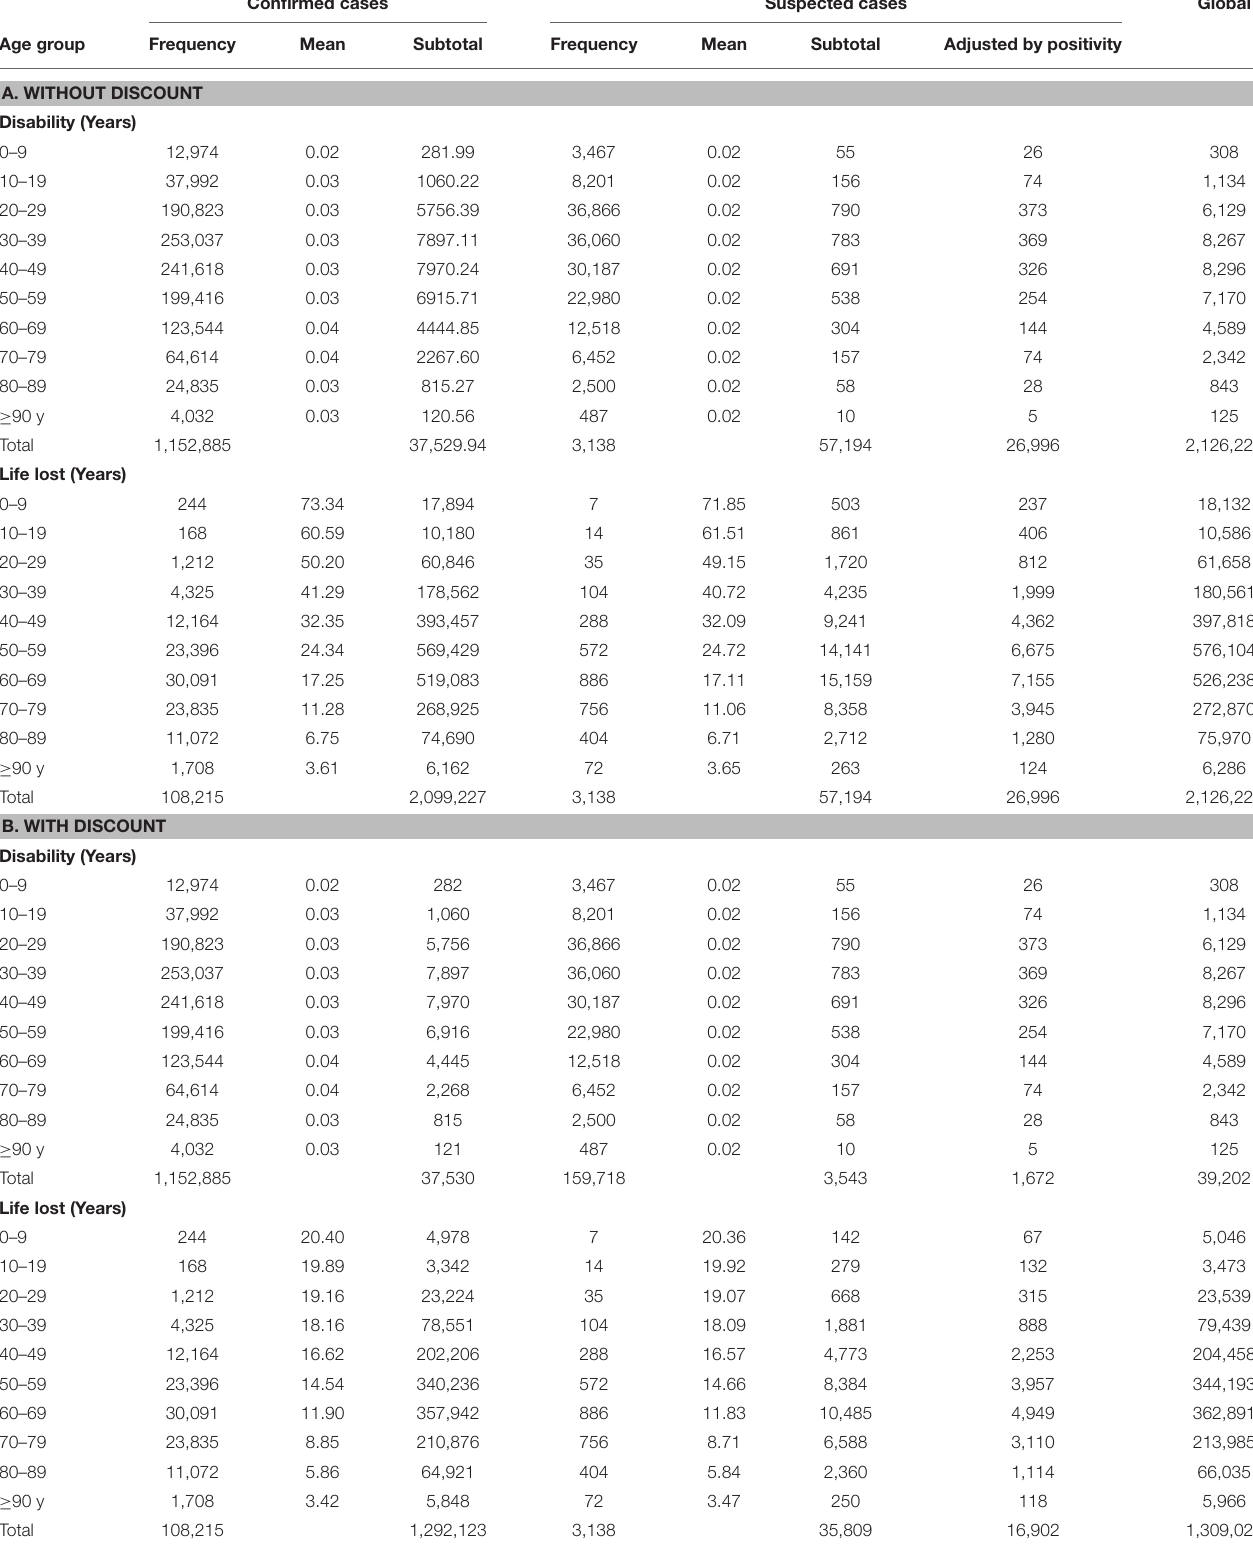
TABLE 3 | Years of life lived with disability (YLDs) and the years of life lost (YLLs) by age